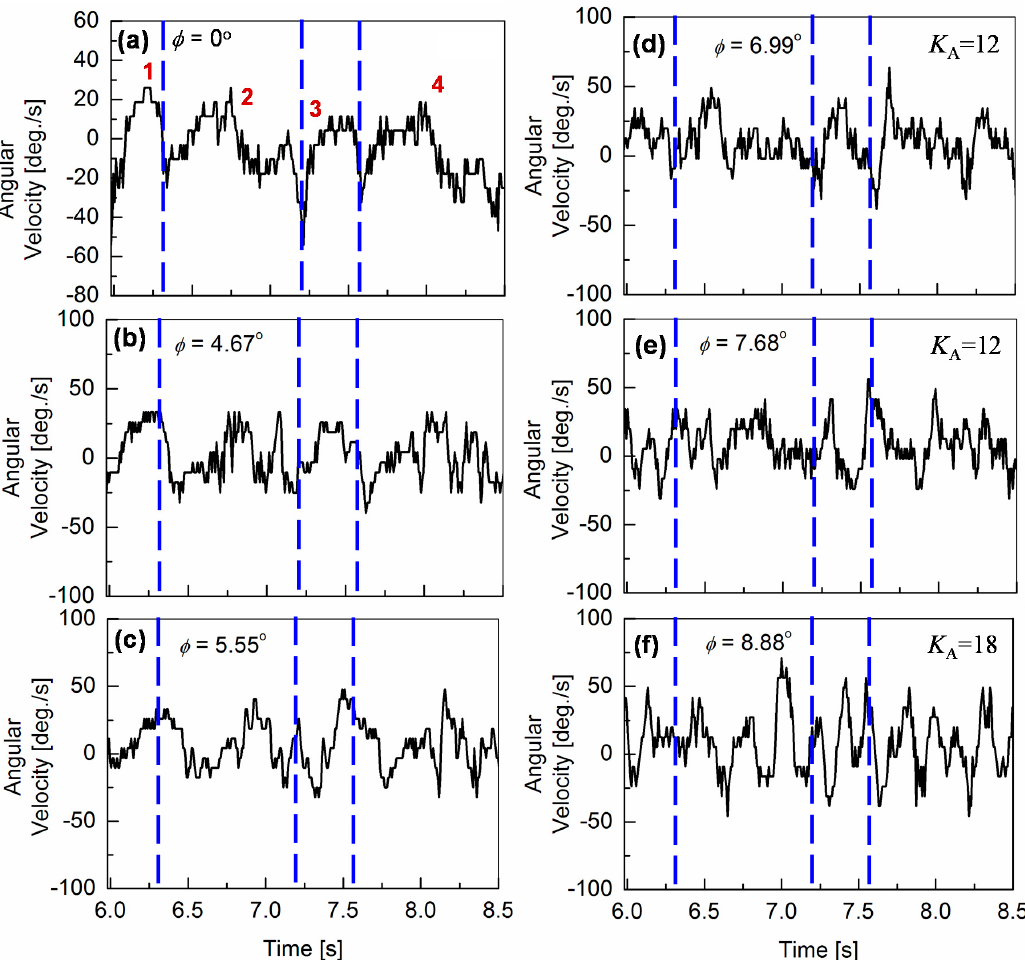
Figure 6. Angular velocities of the robot’s pitch motion during a gait cycle, measured for different surface inclinations. The results are compared with angular-pitch velocities, measured for φ = 0° (see ( a )). An increase in the amplitude and number of oscillations is observed as surface inclination φ is increased (see ( b ) and ( c )). The oscillation increases by greater extent at higher surface inclinations with the feedback control (see ( d ), ( e ) and ( f )). As the surface inclination is increased, the peaks 1, 2, 3, and 4 of the fundamental gait pattern (for φ = 0°) become less distinct due to the increasing additional oscillations.